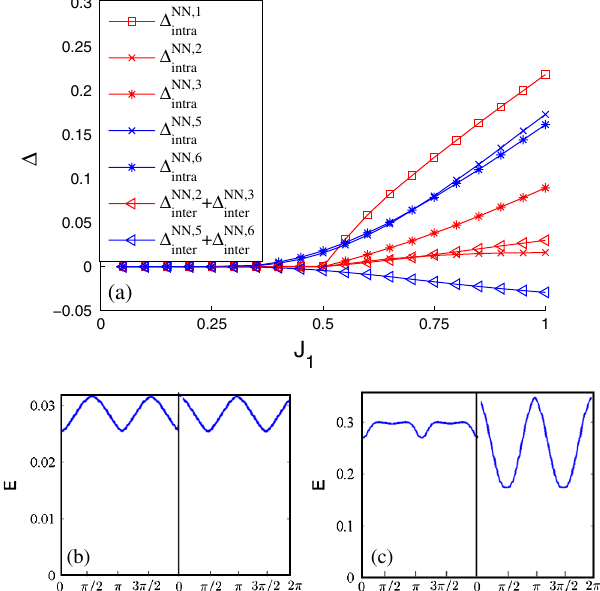
FIG. 4. Mean-field phase diagram as a function of J þ J ¼ 1 in parameter space. along J 1 2